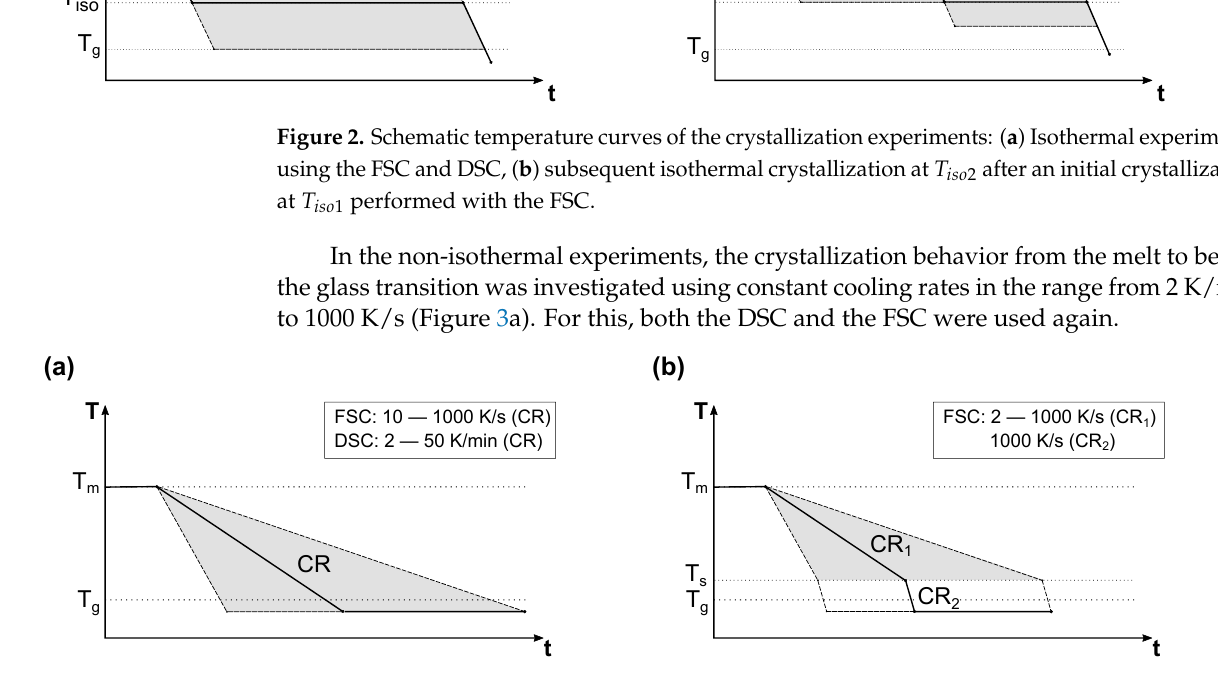
Figure 3. Schematic temperature curves of the non-isothermal crystallization experiments: ( a ) conven- tional non-isothermal experiments at constant cooling rates (CR) using the FSC and DSC in order to determine X CF , ( b ) non-isothermal experiments for the determination of X MAF using the FSC. There- fore, the cooling rate is changed at T s in order to prevent kinetic influences on the subsequent